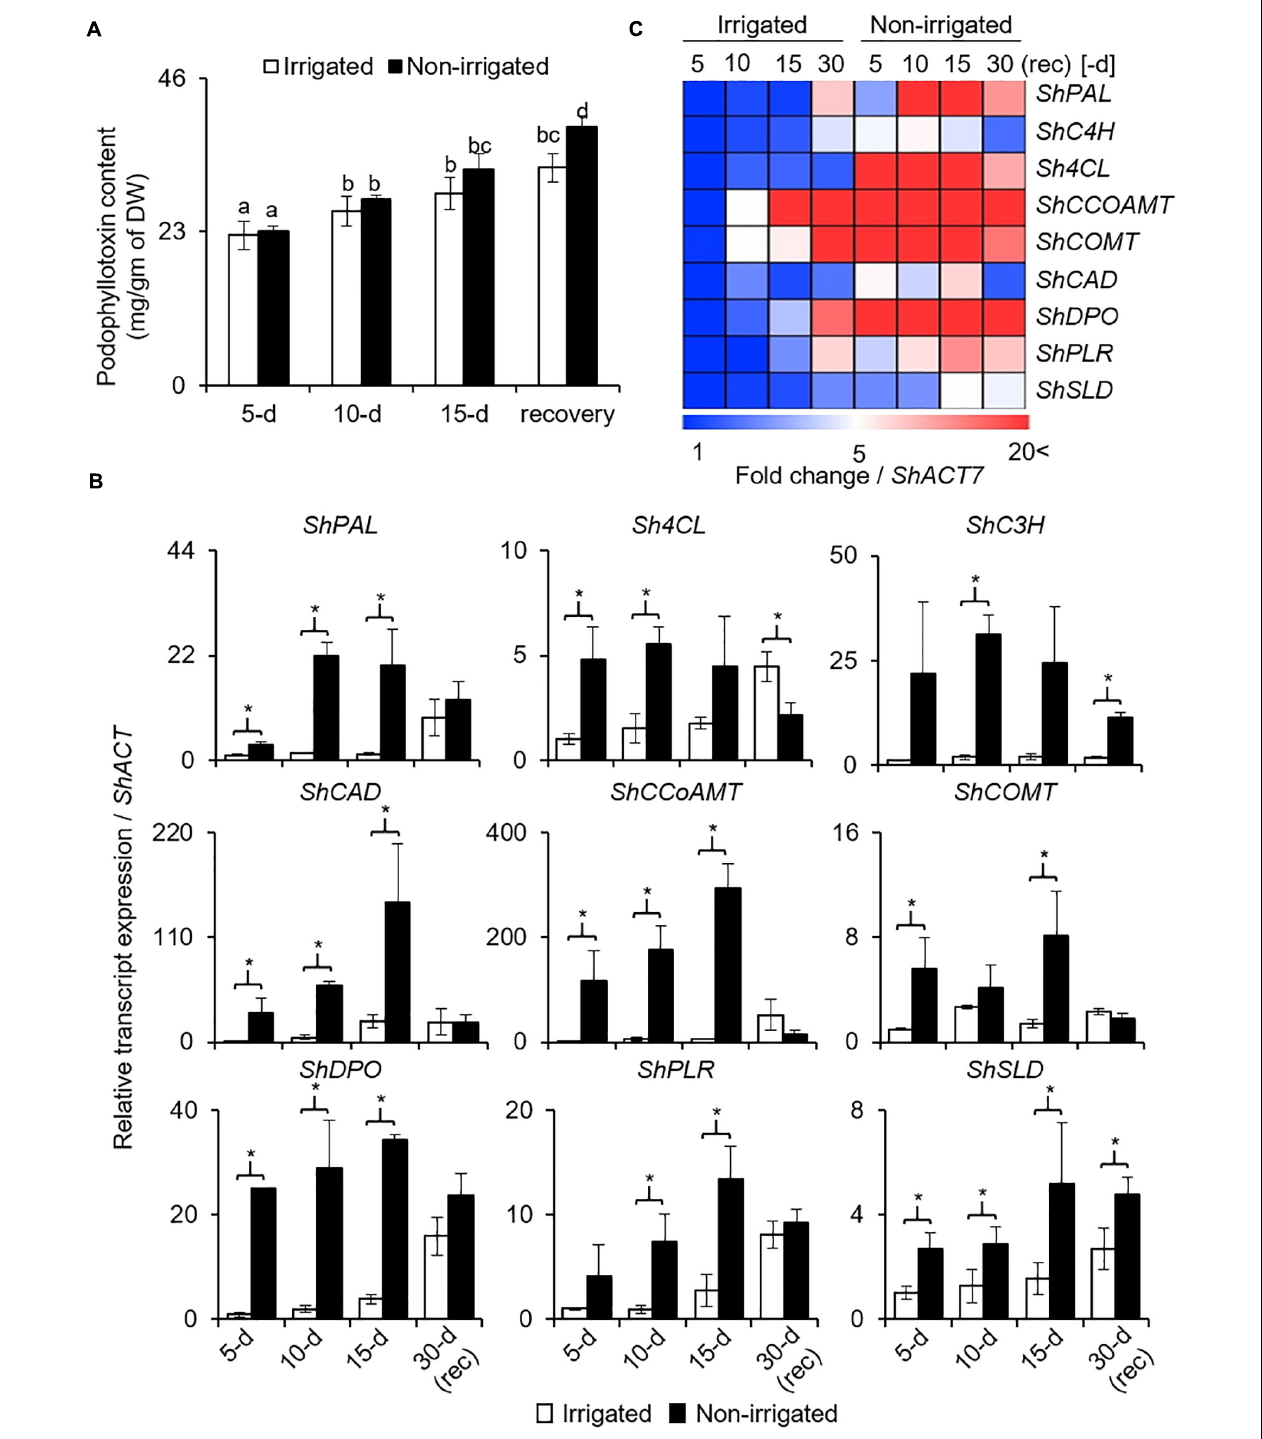
FIGURE 6 | Podophyllotoxin (PTOX) content and expression of biosynthetic pathway genes in S. hexandrum increased in response to water deficit. (A) PTOX content. Data show mean ± SE of three independent biological replicates. Lowercase letters represent statistical significance of differences between the mean values ( P < 0.05, Duncan’s multiple comparison test). (B) Transcript level expression of PTOX biosynthetic pathway genes. Gene names are prefixed with Sh that stands for Sinopodophyllum hexandrum . ShACTIN was used as an internal control. Data represent mean ± SD of three independent biological replicates. Asterisk show statistical significance of differences between the mean values ( P < 0.05, Student’s t -test). (C) Heat map showing the expression of PTOX biosynthetic pathway genes as shown in panel (B) .